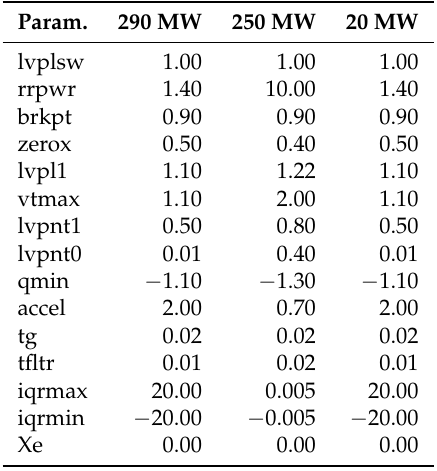
Table A1. REGC-A model: parameters of the solar PV plant. Param. 290 MW